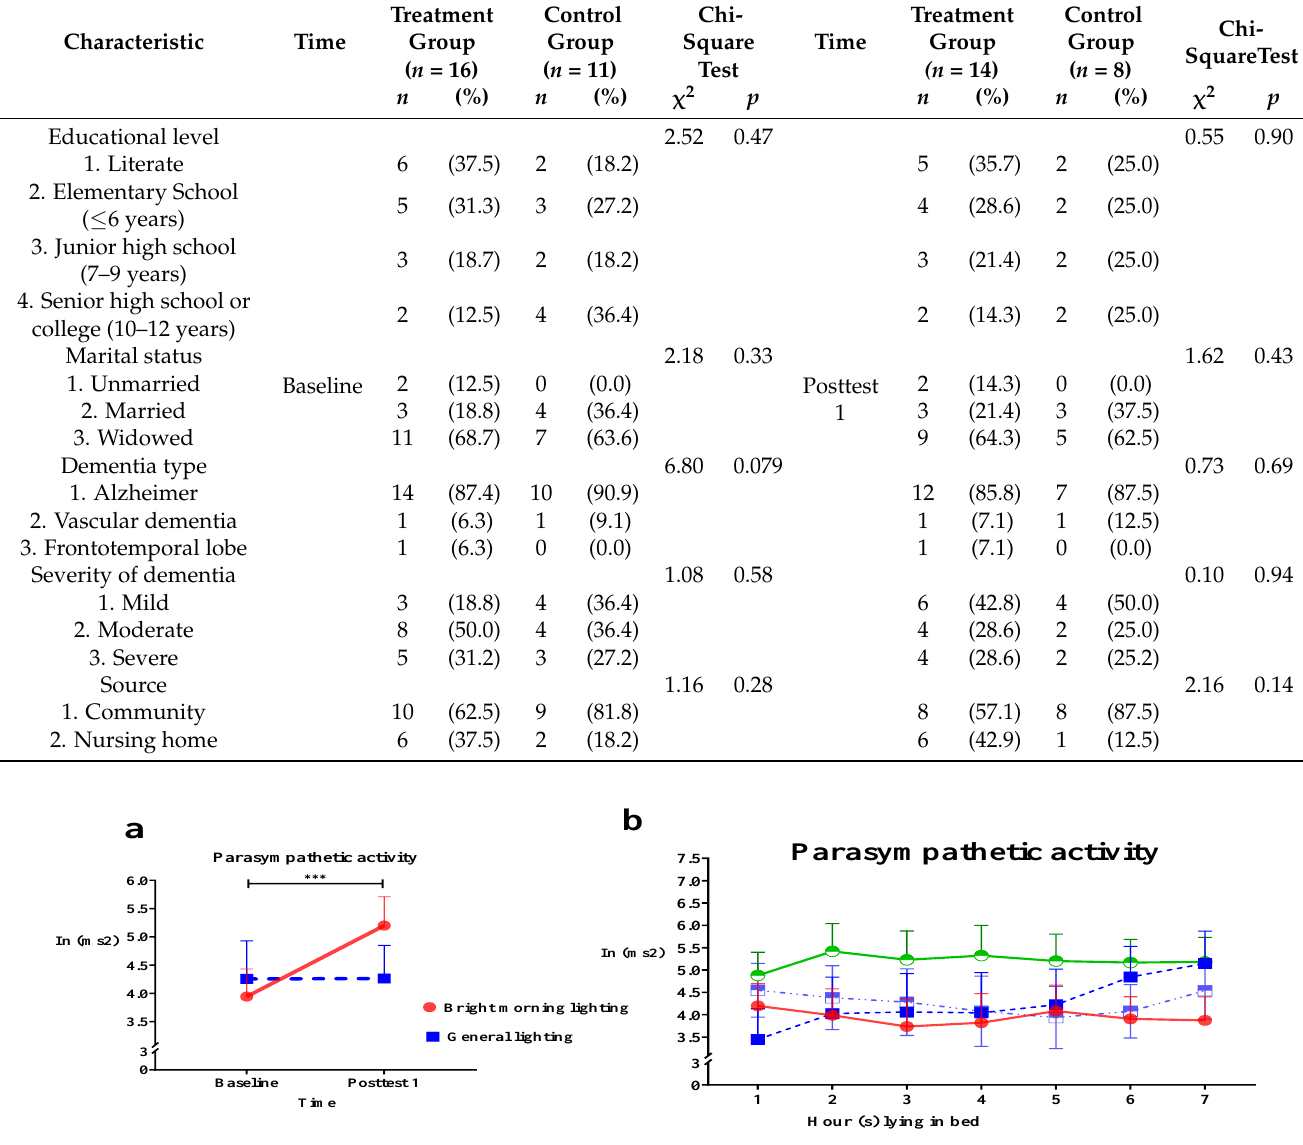
Table 1. Participants’ characteristics at baseline and posttest 1.